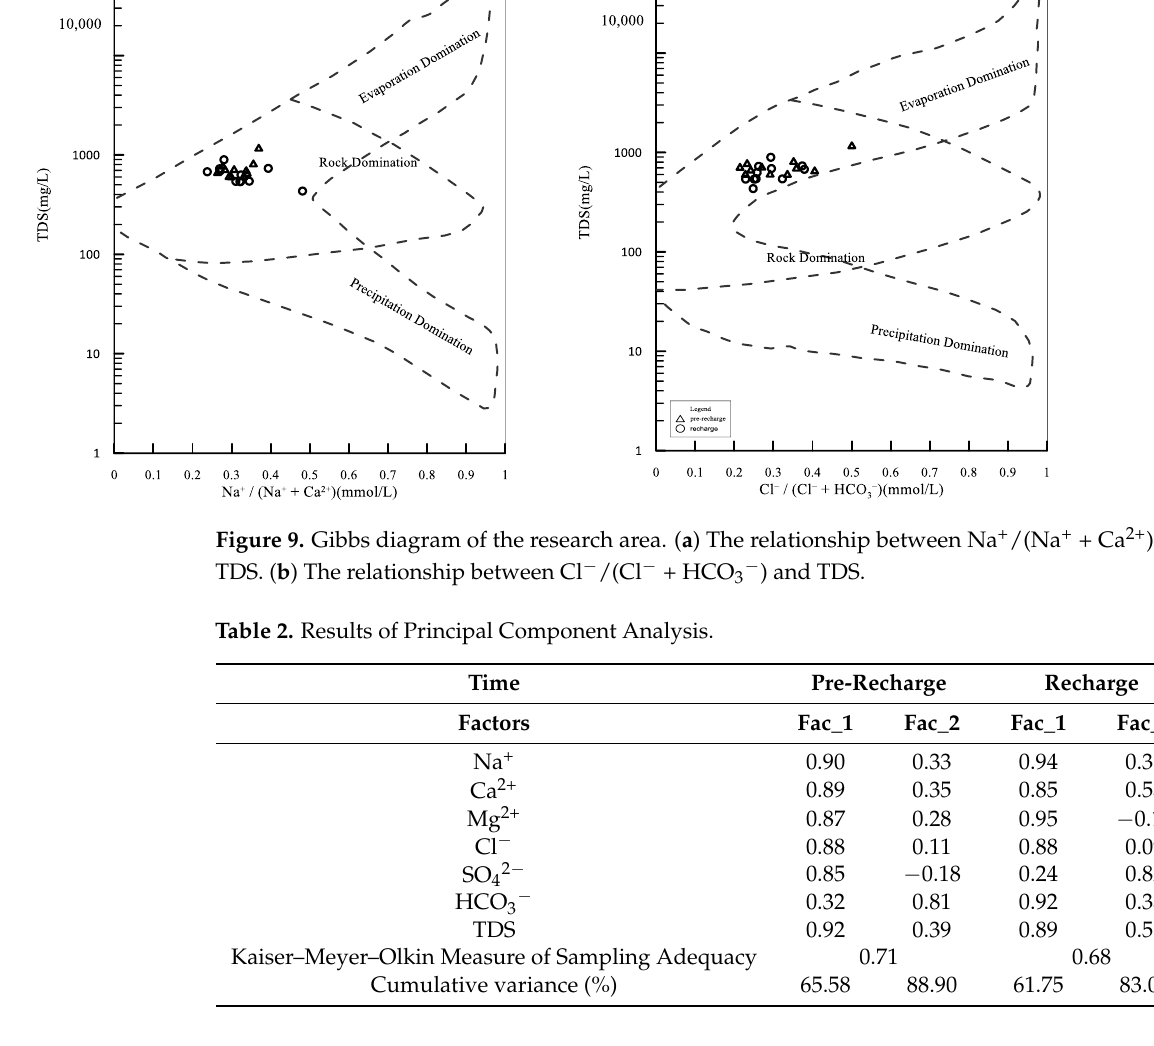
Table 2. Results of Principal Component Analysis.